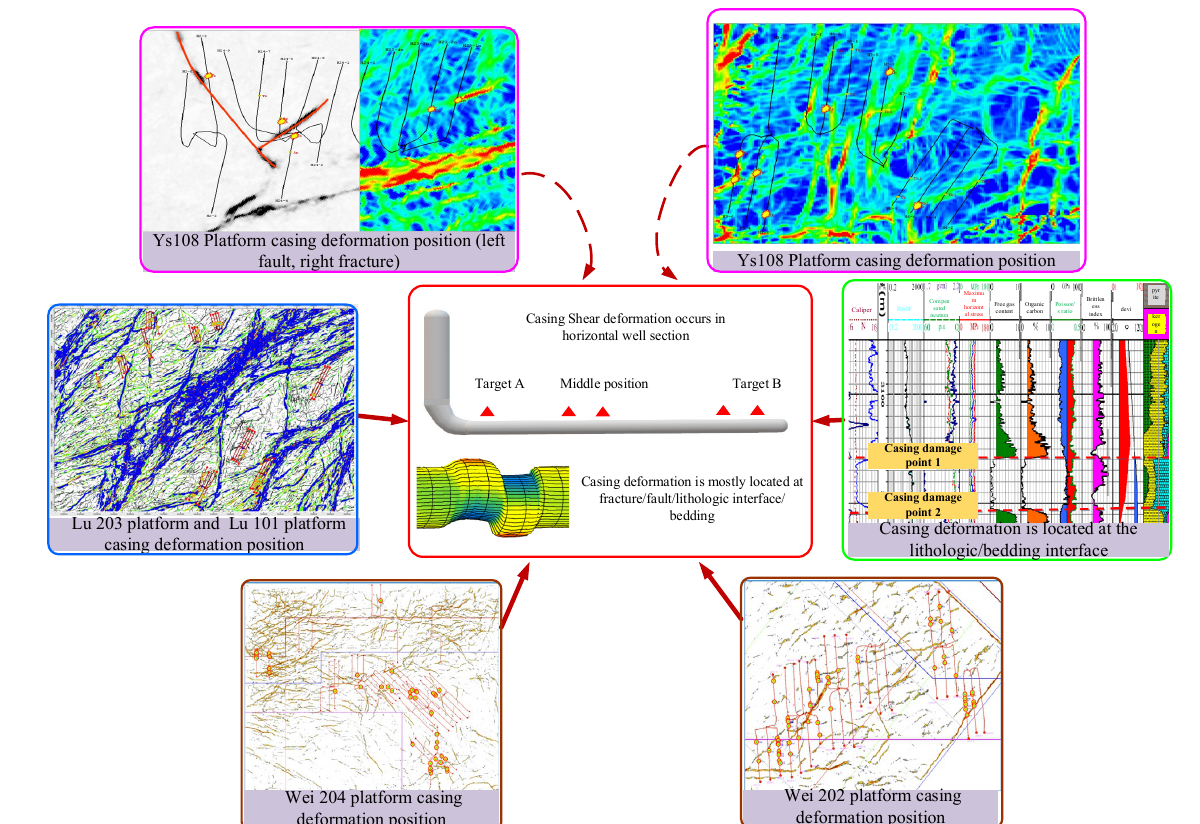
Figure 3. Location of casing deformation in different blocks.